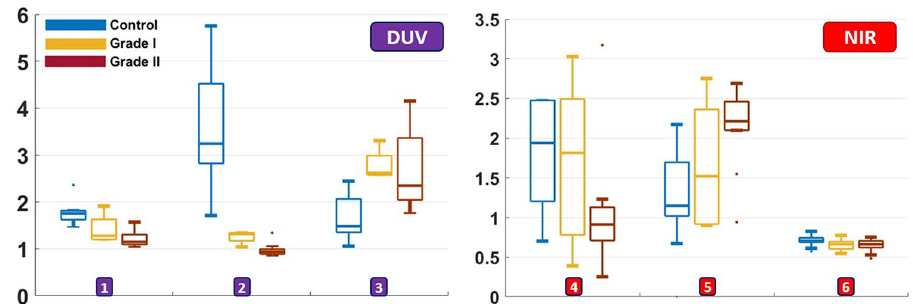
Figure 5. Group boxplots of six molecular ratios acquired from spectral data at 275 nm (DUV) and 810 nm excitation (NIR) for control, grade I and grade II meningioma. DUV part shows Tryptophan/Collagen (N1), Tryptophan/NADH (N2) and Tryptophan/Tyrosine (N3) ratios. NIR part shows PN ratio (Porphyrins/NADH) (N4), ratio LP (Porphyrins/Lipopigments + Porphyrins) (N5) and redox ratio (FAD/ (NADH + FAD)) (N6) ratios.